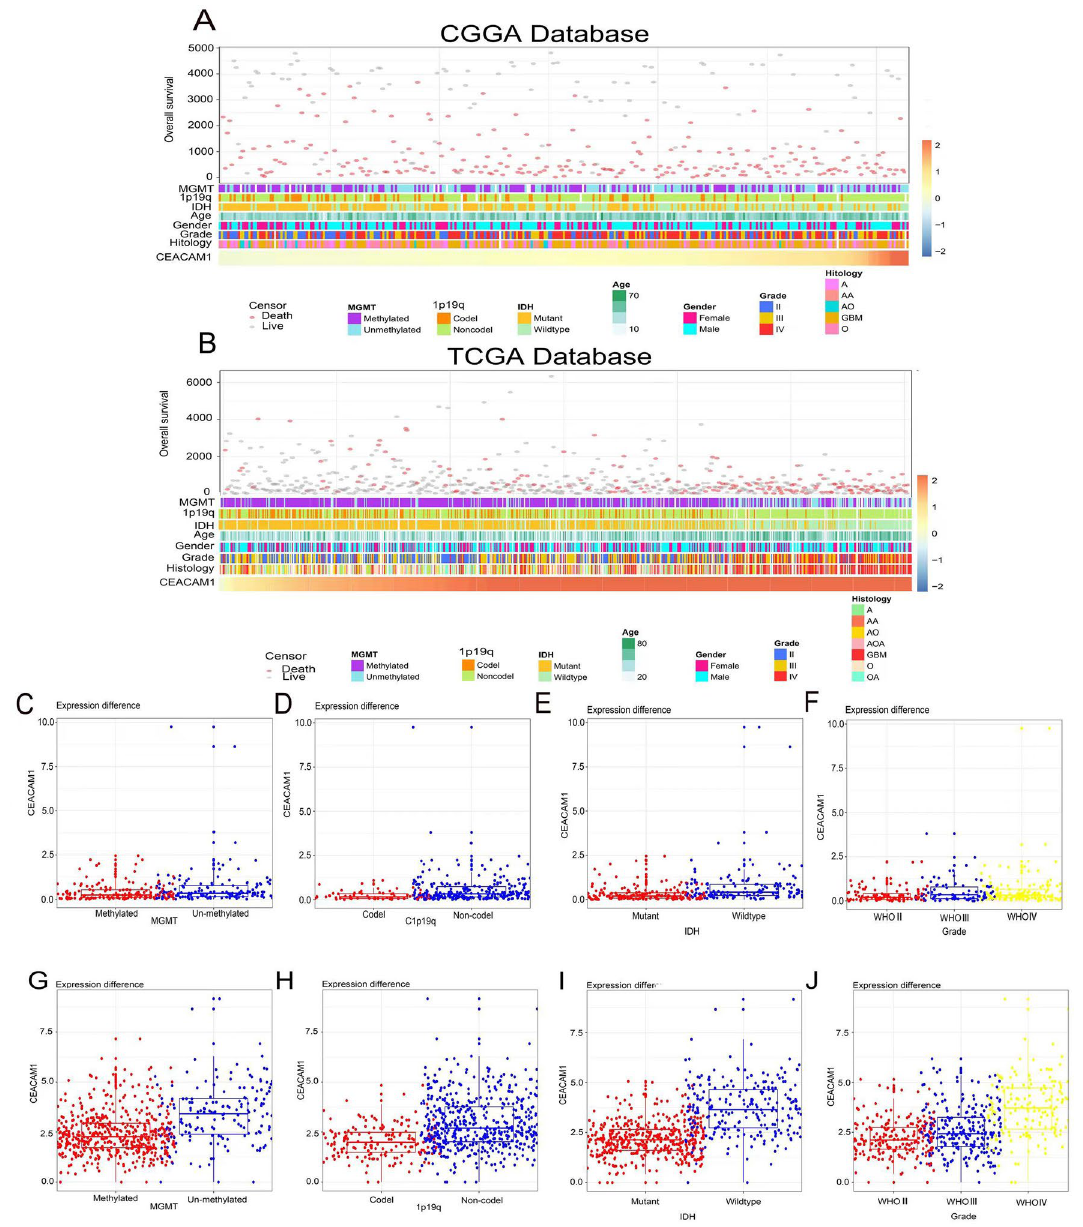
Fig. 7 Association between CEACAM1 and clinicopathological characteristics of gliomas. A The landscape of CEACAM1-related clinicopathological features of gliomas in the Chinese Glioma Genome Atlas (CGGA) database. B The landscape of CEACAM1- relatedclinicopathological features of gliomas in the The Cancer Genome Atlas (TCGA) database. C – F Distribution of glioma-related gene CEACAM1 in MGMT, IDH, Grade and 1p19q. G–J Distribution of glioma-related gene CEACAM1 in MGMT, IDH, Grade and